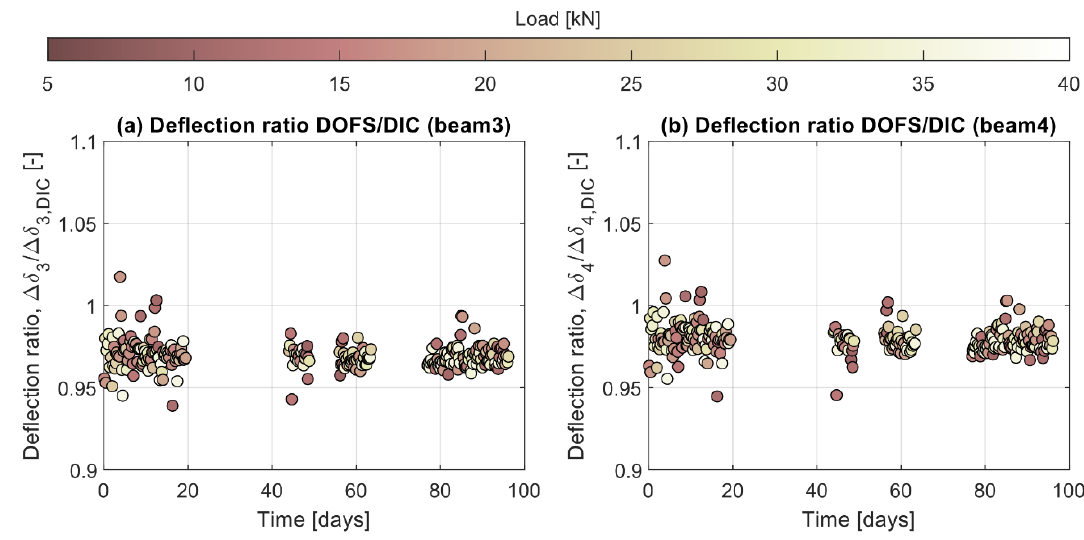
Figure 11. Ratio of the deflection increment calculated from the DOFS and measured by the DIC for ( a ) beam 3 and ( b ) beam 4.